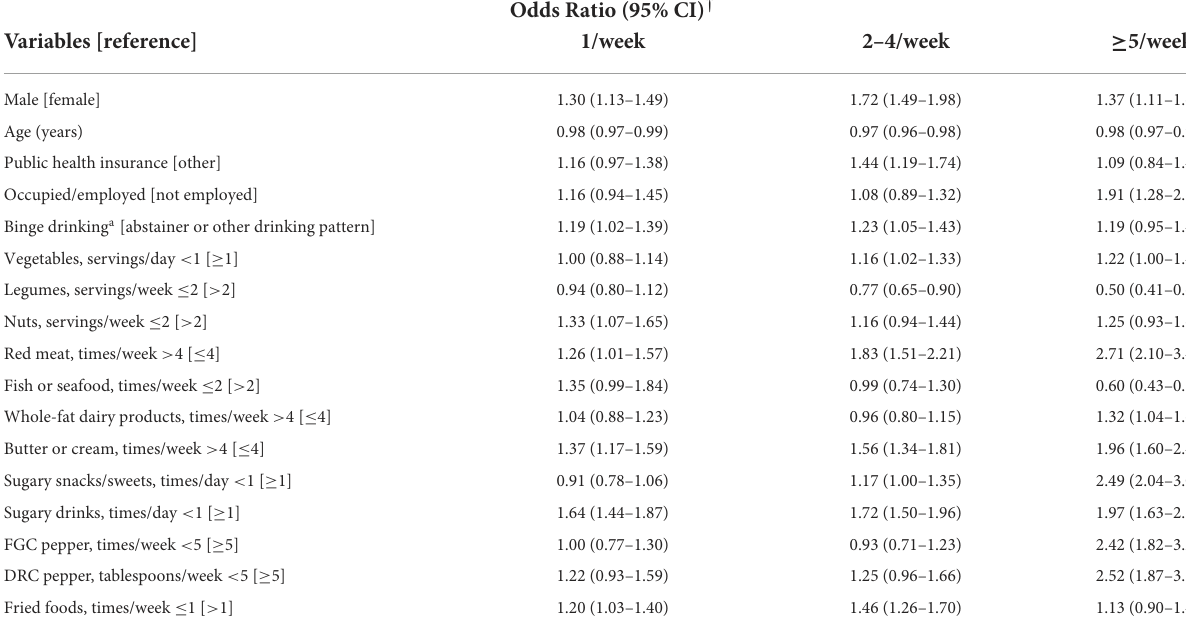
TABLE 5 Sociodemographic and diet factors associated with processed meat